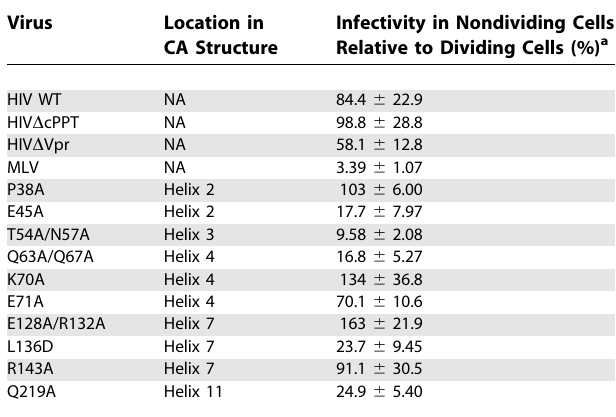
Table 1. HIV Mutants Tested for Their Ability to Infect Nondividing Cells Virus Location in CA